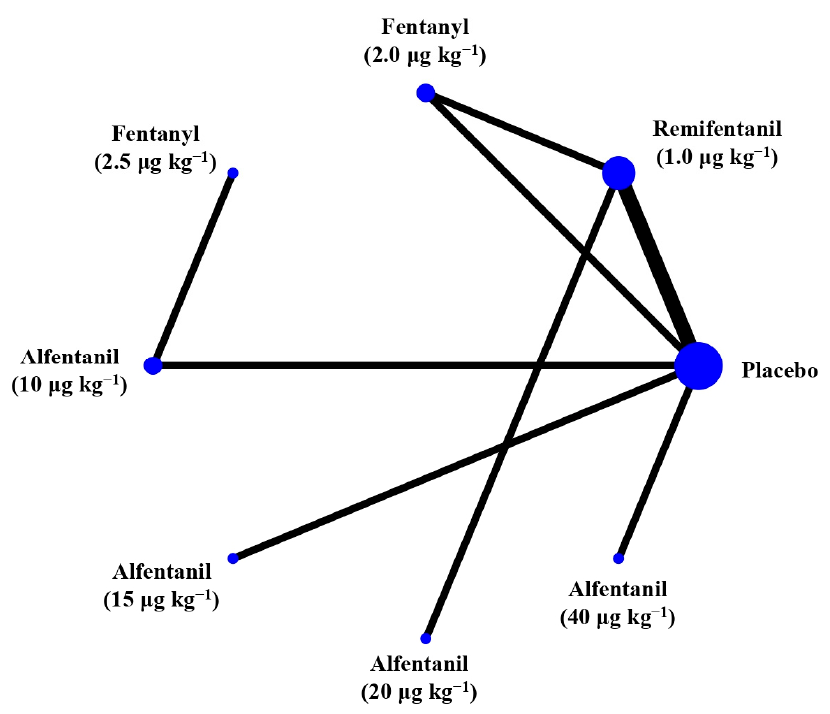
Figure 6. The network treatment comparisons for studies investigating the effects of short-acting